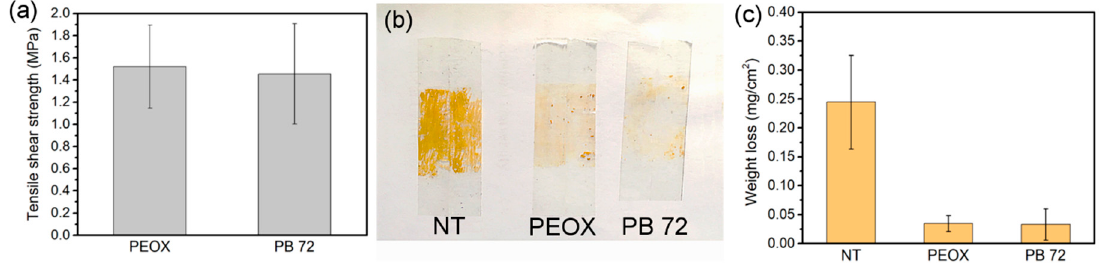
Figure 6. ( a ) Single-lap joint shear strength of PEOX and PB 72; ( b ) Consolidation efficiency test by tape test on painted samples. “NT” stands for the not treated sample; ( c ) Weight loss of pigment on the untreated sample and the sample treated with PEOX and PB 72 respectively by the Scotch tape test.